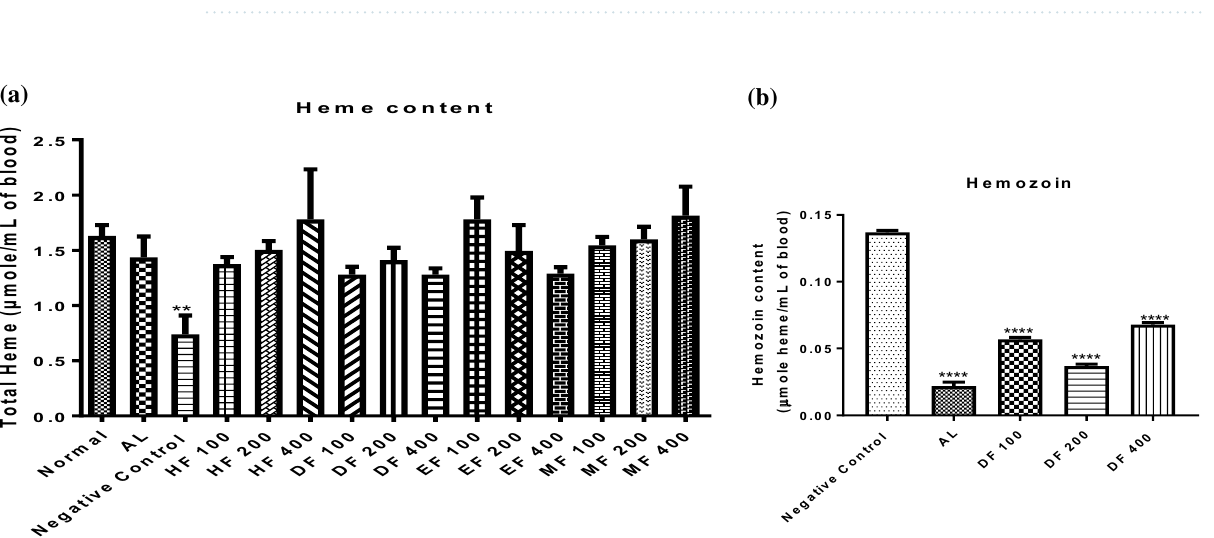
Table 2. Mean haematological parameter of P. berghei infected mice after treatment with D. mespiliformis extract. Neut = Neutrophils, Lym = Lymphocytes, Mono = Monocytes and Eosin = Eosinophils. * = P < 0.05 normal control versus test groups.